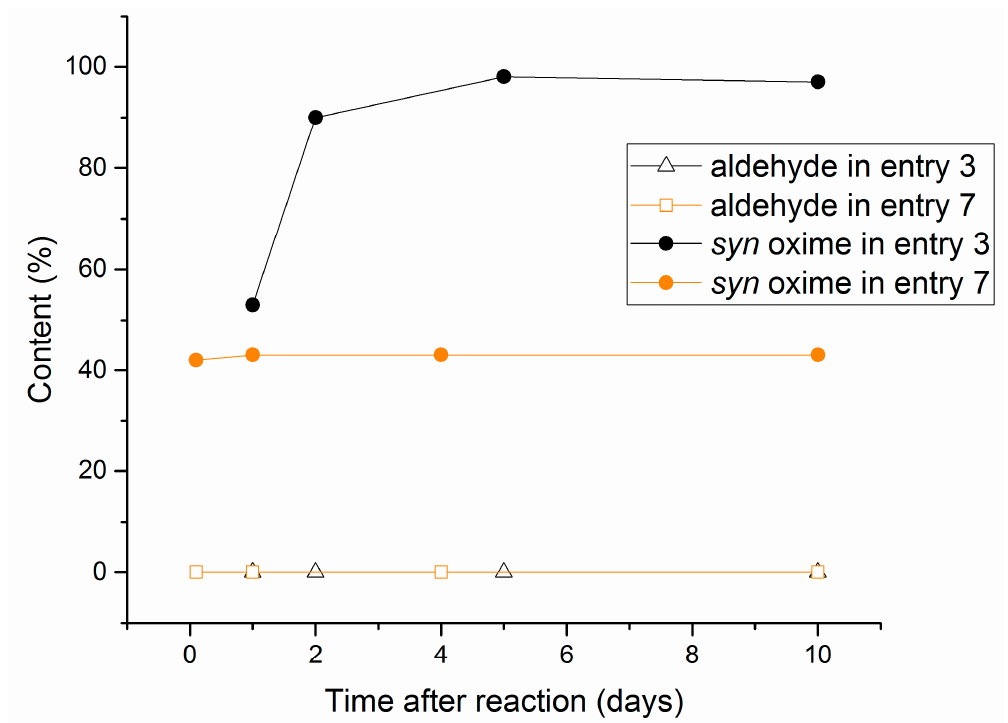
Figure 2. Amounts of non-reacted aldehyde 1 and syn oxime 1a in selected experiments performed with a Pulverisette 7 Premium Line mill in a WC jar determined from 1 H-NMR spectra. Time of milling for entry 3: 20 min and for entry 7: 40 min. In entry 3, 5 eq. NH 2 OH · HCl and 2 eq. NaOH were used. In entry 7, 5.2 eq. NH 2 OH · HCl and 2.7 eq. Na 2 CO 3 were used. The data reported after 10 days are for the washed samples.